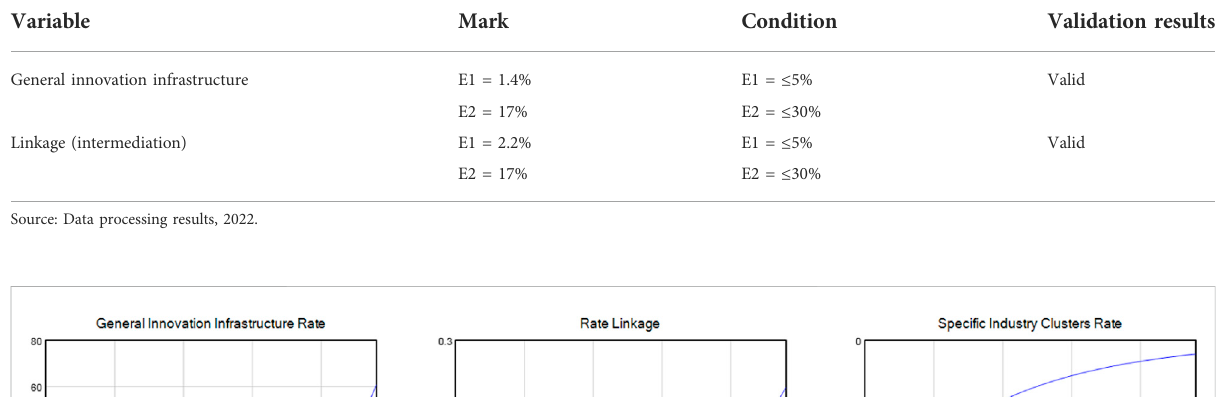
TABLE 2 Quantitative test validation results.